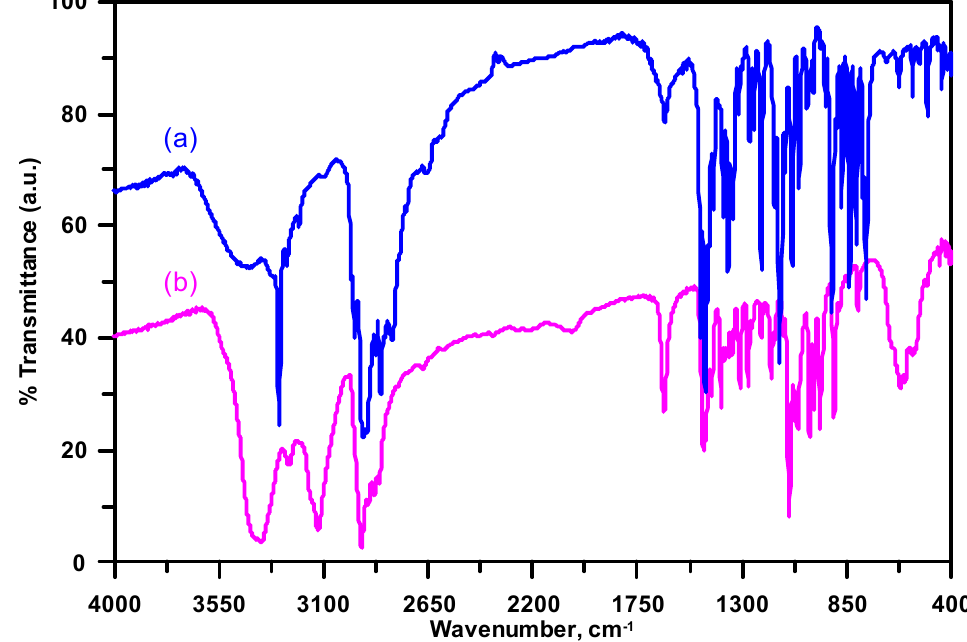
Figure 4. FT-IR spectra of ( a ) free ligand L 1 (blue line) and ( b ) complex (I) (pink line), respectively.